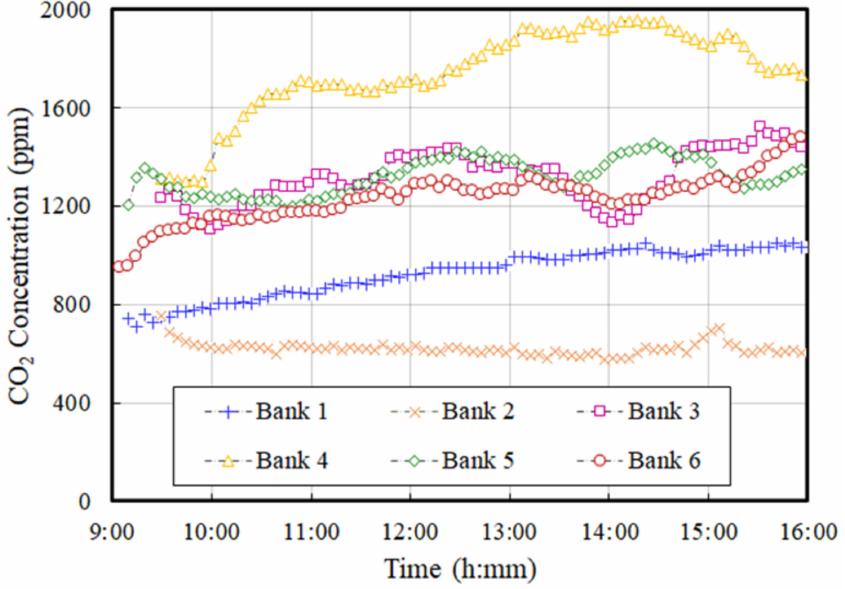
Figure 4. Time-series plot of CO 2 in operation divisions, each point at 5-min interval over the study